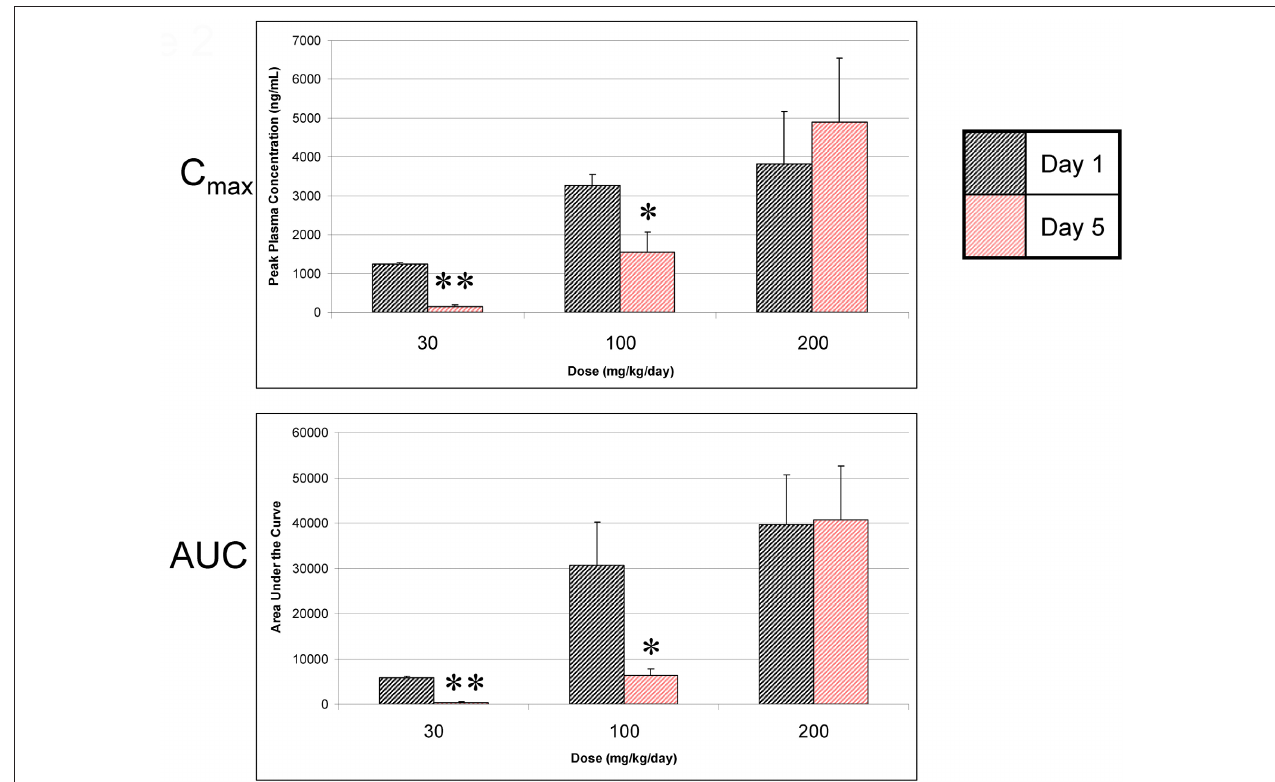
FIGURE 2 | A-998679 peak plasma concentrations ( C max ) and area under the curve (AUC) following oral dosing of rats for 1 or 5 days. Plasma levels are reported as the mean of 3 rats ± SEM in units of ng/ml ( C max ) or ng • h/ml (AUC). The gray bars represent the compound levels on the first day of